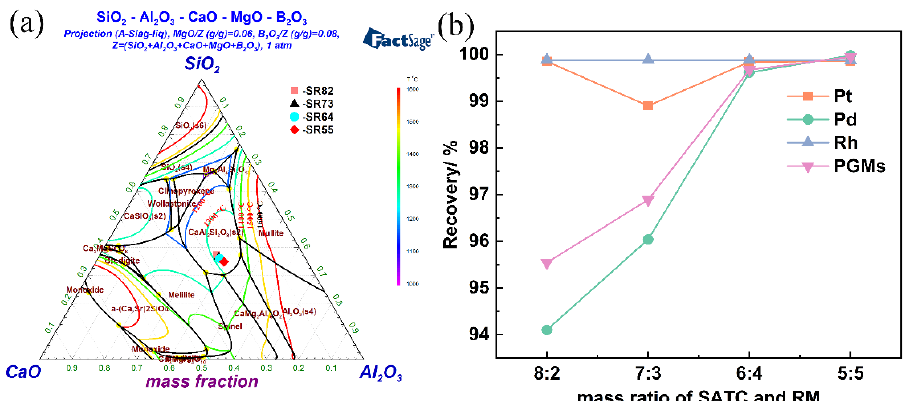
Figure 3. Melting point of mixed wastes of SAC and RM in SiO 2 -Al 2 O 3 -CaO-6 wt%MgO — 8 wt%B 2 O 3 ( a ) and effect of RM addition on PGM recovery ( b ) (H 3 BO 3 addition of 14 wt%, basicity of 0.8, smelting temperature of 1500 °C, and holding time of 40 min).